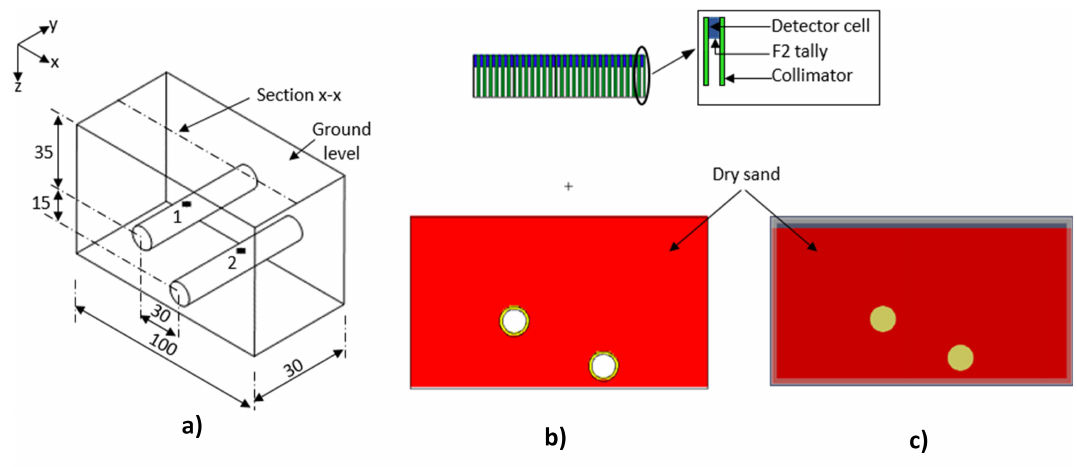
Figure 12. ( a ) Modelled contaminated environment (dimensions in cm); ( b ) MCNPX model with grid of detectors (section x-x); ( c ) gprMax model (section